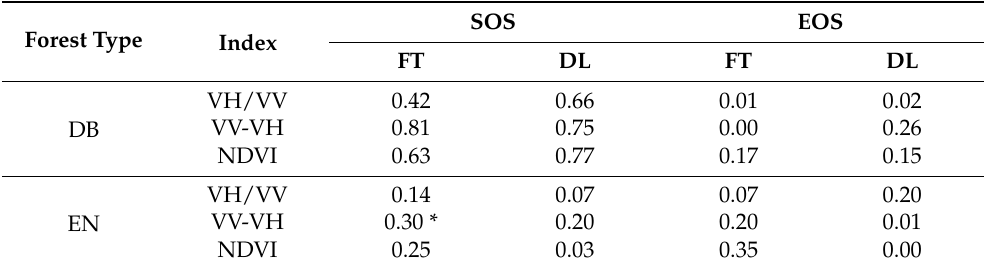
Table 2. Correlation of Sentinel-1 and Sentinel-2 extracted phenological metrics to PhenoCam extracted metrics (shown by R 2 values). SOS EOS Forest Type Index FT DL FT DL VH/VV 0.42 0.66 0.01 DB